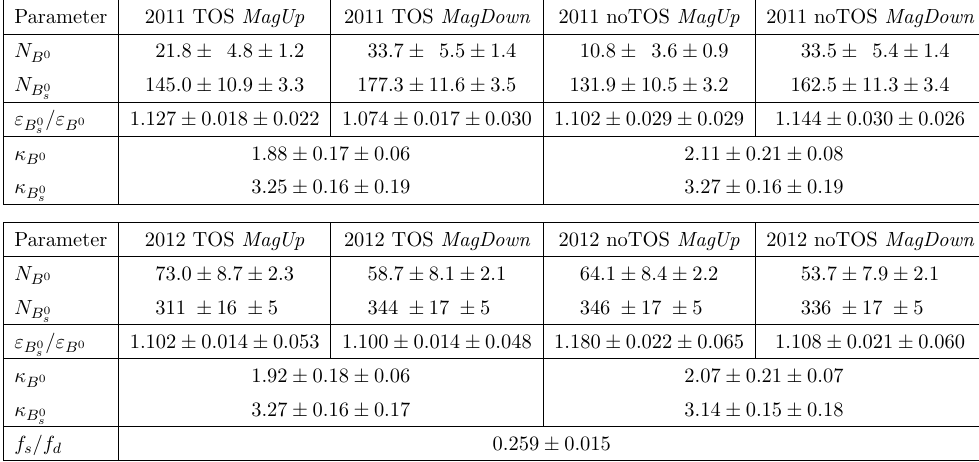
( B 0 K (cid:3) 0 K (cid:3) 0 ) = ( B 0 K (cid:3) 0 K (cid:3) 0 ). When two uncer- s ! B ! B